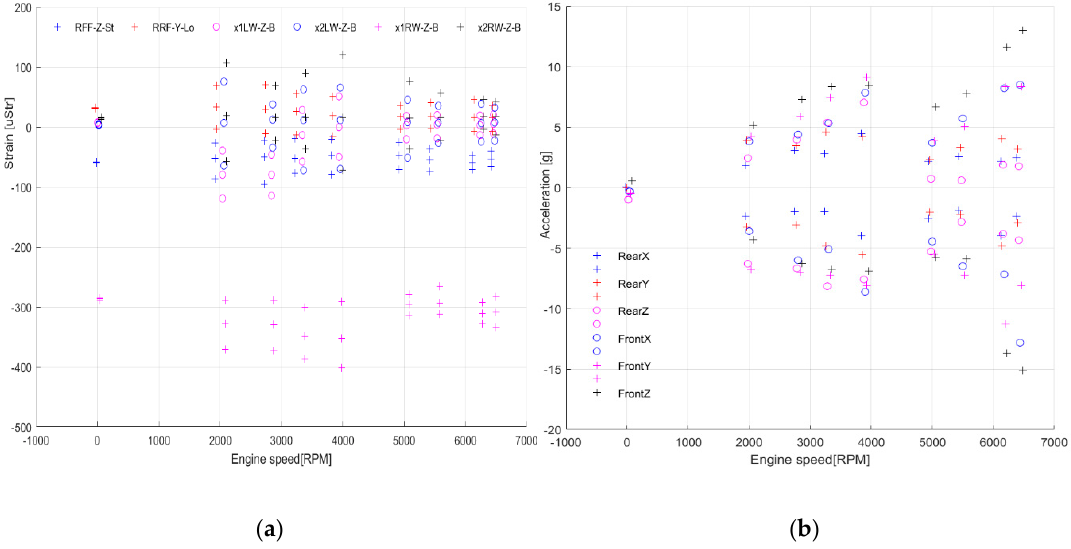
Figure 23. Max / median / min values during engine test for ( a ) strain sensors, and ( b )